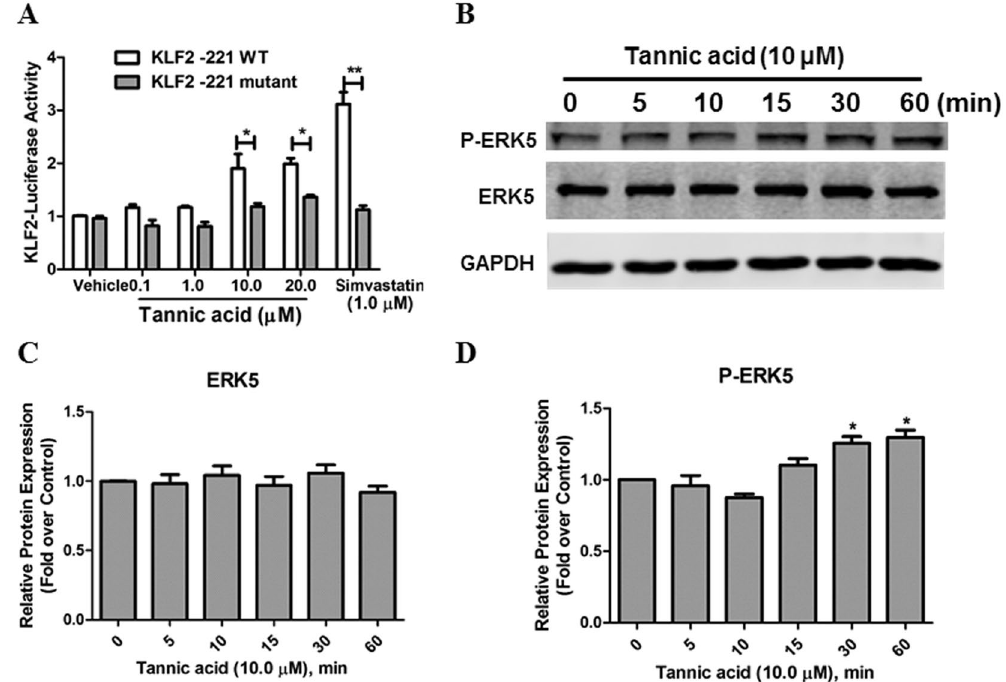
Figure 3. The ERK5/MEF2 pathway is involved in TA-induces KLF2 expression. ( A ) COS-7 cells were transfected with KLF2 -221 WT or KLF2 -221 mutant plasmids, treated with TA (10.0 µ M), DMSO (vehicle) or simvastatin (1.0 µ M, positive control) for 24 h, and luciferase activities were then detected. * P < 0.05. n = 3. ( B – D ) HCAECs were pretreated with TA (10.0 µ M) for 0, 5, 10, 15, 30 and 60 min, respectively, then protein expression of phospho-ERK5, ERK5 and GAPDH were determined by Western blotting. * P < 0.05. n =